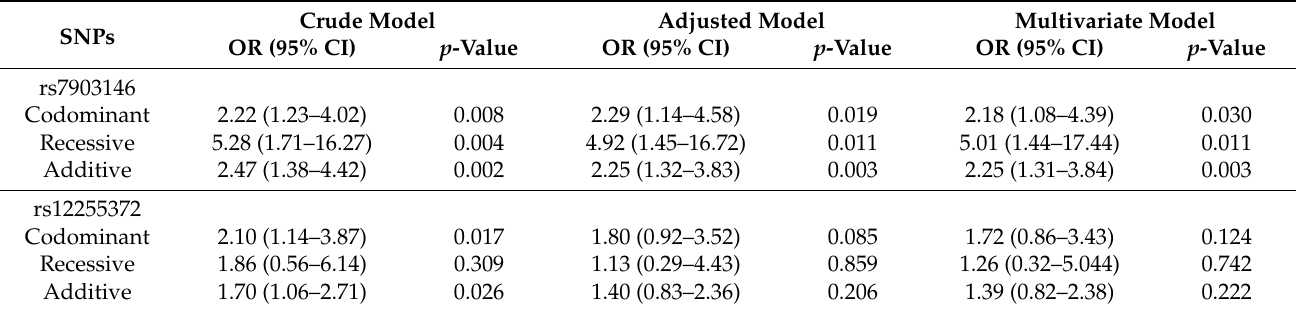
Table 3. Association between rs12255372 and rs7903146 and